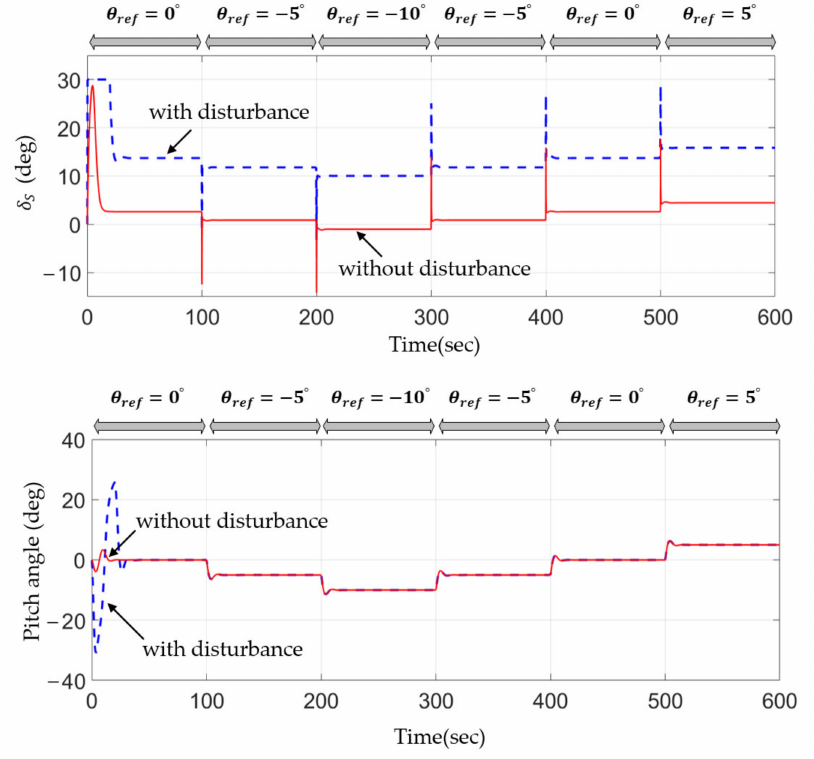
Figure 12. Simulation results when − 200 Nm disturbance is applied for Case